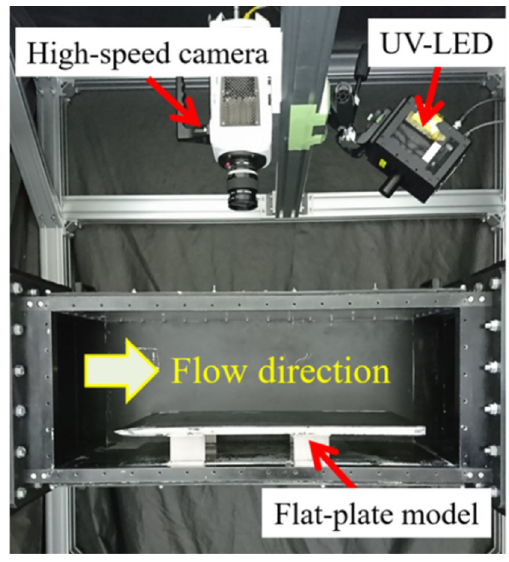
Figure 1. Experimental set-up: model with luminescent mini-tufts and photography device, Reprinted with permission from Ref. [30]. 2019, Elsevier .